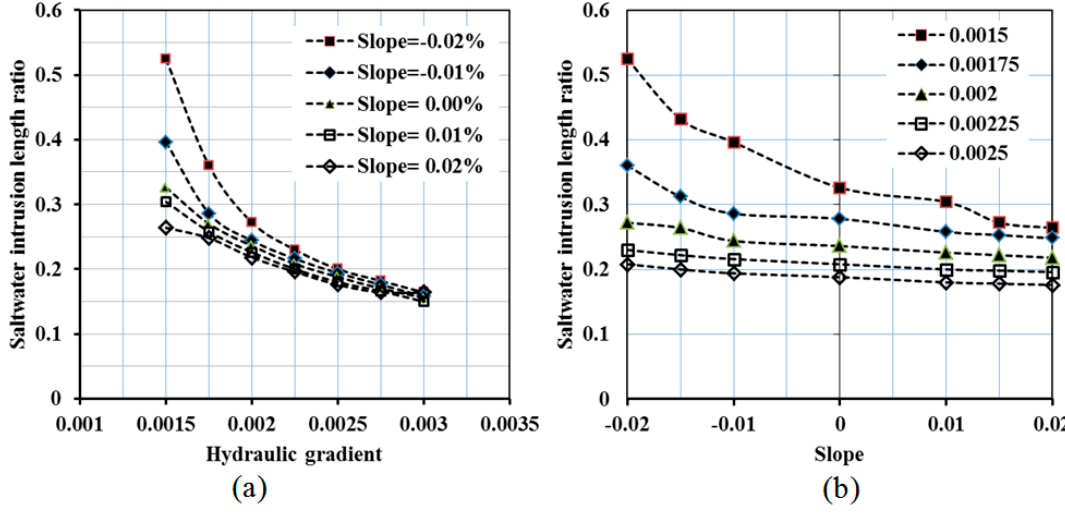
Figure 3. Relationship between ( a ) the hydraulic gradient and SWI length ratio and ( b ) the bed slope and SWI length ratio.